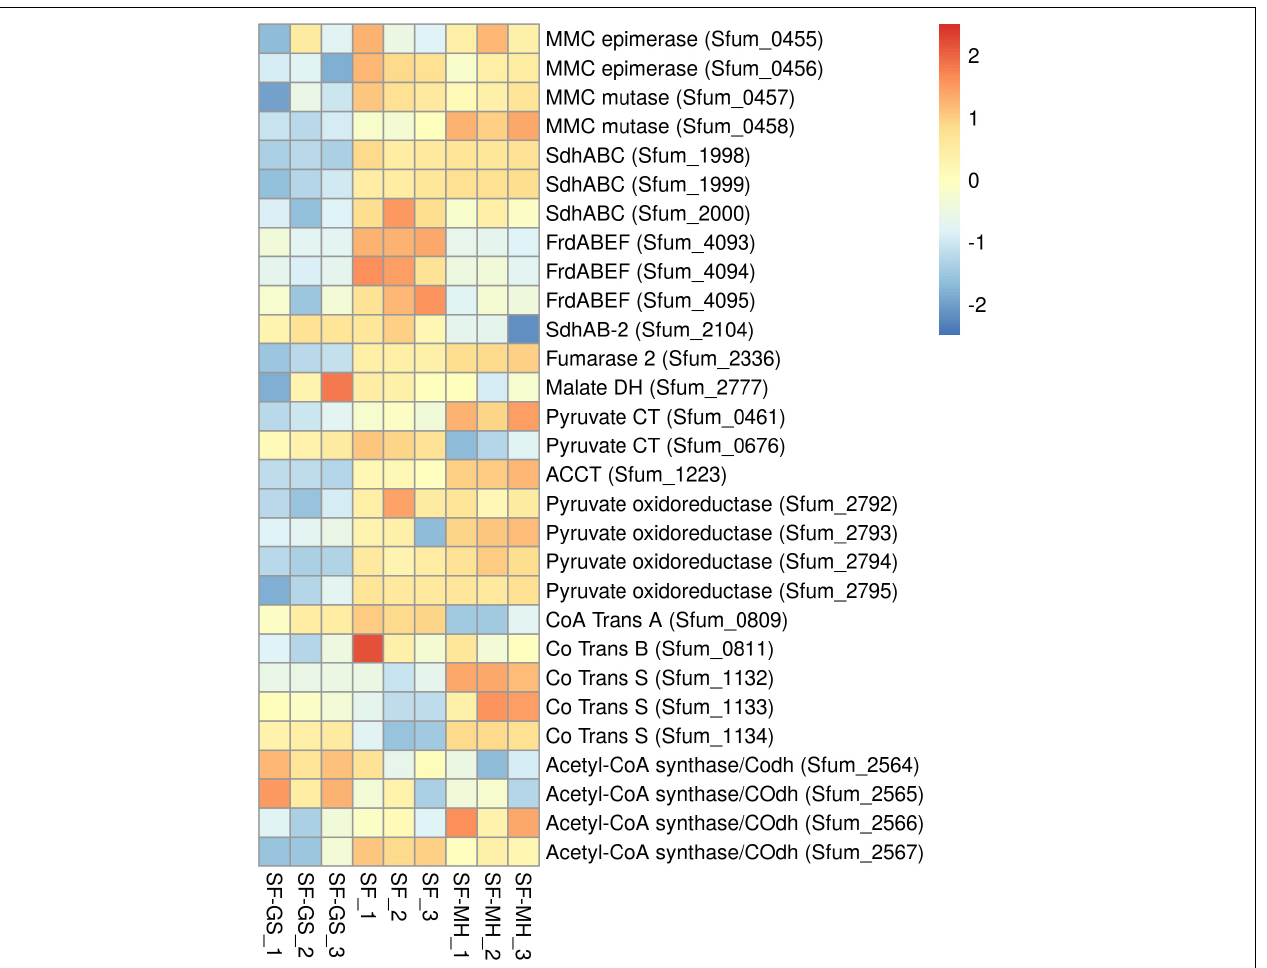
FIGURE 3 | Relative abundance of the detected proteins in the methylmalonyl-CoA pathway of SF in the SF-GS coculture versus the SF pure culture and the SF-MH coculture. Protein abundance levels are shown after Z -score normalization. The colour intensity indicates the degree of protein presence, where high relative abundance is indicated in red and low relative abundance in blue. The rows in the heat map show the detected proteins in the SF-GS coculture, the SF pure culture and the SF-MH coculture. The columns show the cultures in triplicates. Clustering shows that samples grouped according to treatments even when only enzymes in this set are considered ( Supplementary Figure 6